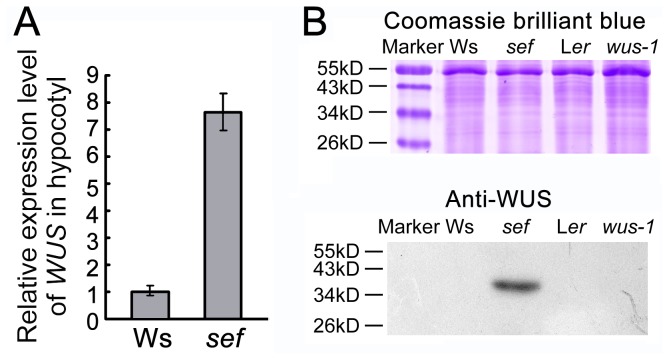

WUS is expressed ectopically in hypocotyls of sef.(A) Expression of WUS in hypocotyls of Ws, sef, Ler and wus-1 detected by qRT-PCR. Data are means ± SD (n = 3). (B) Immunoblot analysis of WUS protein in hypocotyls of Ws, sef, Ler and wus-1. Upper panel, coomassie brilliant blue (CBB)-stained SDS-PAGE gel. Bottom panel, immunoblotting of WUS protein.